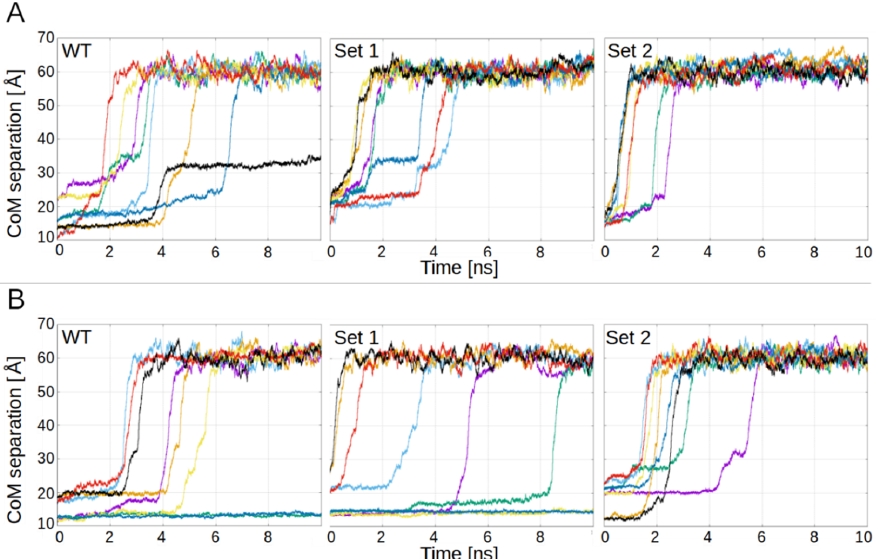
Figure 2. PL1 unbinding from receptors. ( A ) harmonic restraint-driven unbinding of PL1 from WT FN-EDB, mutant Set 1 FN-EDB (D12N, D49N, D52N), and mutant Set 2 FN-EDB (D12N, D49N, D52N and D68N, D70N); ( B ) harmonic restraint-driven unbinding of PL1 from WT TNC-C, mutant Set 1 TNC-C (D13N, E70Q, E88Q), and mutant Set 2 TNC-C (D13N, E70Q, E88Q and D39N, D45N). Each simulation is represented in a different color.